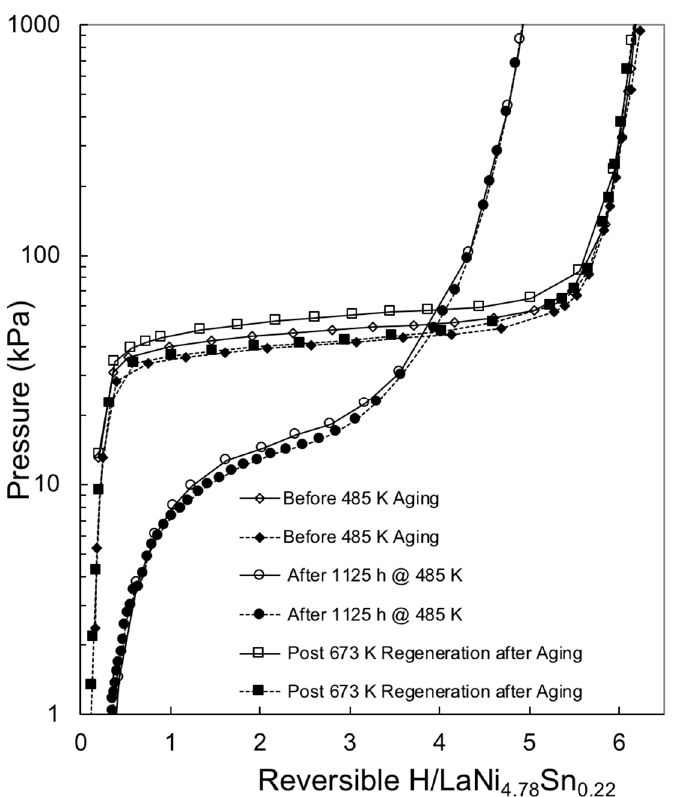
Figure 9. Hydrogen isotherms measured at 300 K for a LaNi 4.78 Sn 0.22 H x alloy after activation and before aging, after 1125 h aging at 485 K with a pressure > 171 bar and initial x = 5.10, and following a vacuum regeneration at 673 K after aging: Open symbols and solid lines represent absorption while filled symbols and dashed lines desorption (Adapted from Reference [29] (2019, with permission from Elsevier).